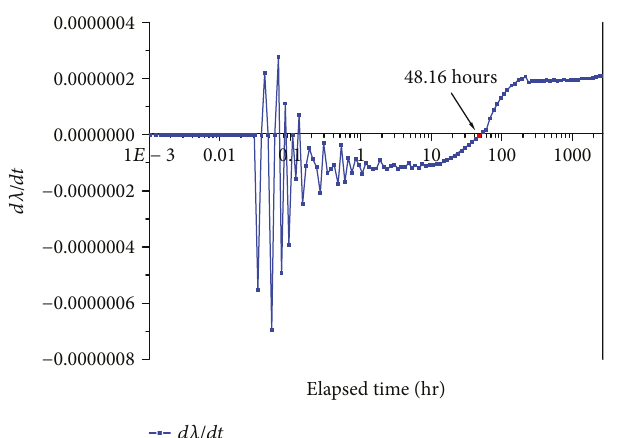
Figure 9: The total mobility derivative curve just upstream of the saturation front ( r → r + ); the total mobility derivative is positive f and increasing with time (at early time, the calculation results are not stable due to numerical dispersion).